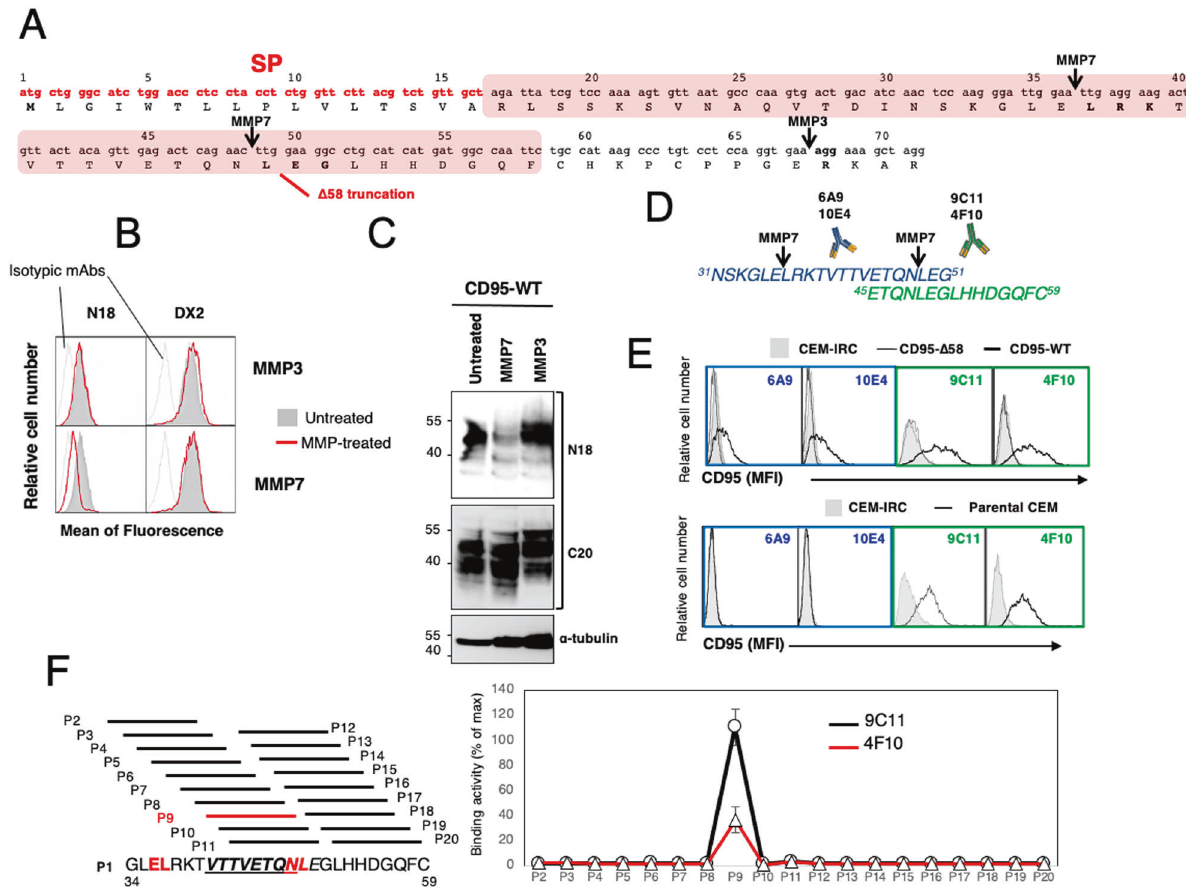
Fig. 3 MMP7-mediated cleavage of the CD95 N-terminal domain. A Schematic representation of the predicted metalloprotease (MMP) cleavage sites in the amino terminal region of CD95 [26]. Box in red refers to the truncated CD95- Δ 58 construct. SP refers to signal peptide. B CEM-IRC cells reconstituted with full-length CD95 were incubated with (red line) or without ( fi lled grey curve) recombinant MMP-3 or MMP-7 (0.1 µg/ml) for 4 h at 37 °C and CD95 expression was assessed by fl ow cytometry using N18 or DX2. Isotypic antibodies for N18 and DX2 are depicted. C CEM-IRC cells reconstituted with full-length CD95 (CD95-WT) were treated as in (B), lyzed and indicated western blotting were performed. Tubulin immunoblot serves as loading control. D The two peptides covering the N-terminal region of CD95 have been injected in mice to generate anti-CD95 mAbs. E Flow cytometry analyses of the CD95 constructs recognized by monoclonal antibodies in ( D ). 9C11 and 4F10 recognize endogenous CD95 (parental cells), while 6A9 and 10E4 fails to recognize it. ( F ). Epitope mapping of 9C11 and 4F10 antibodies as described in Materials and methods. Left panel; indicated overlapping peptides covering the CD95 amino acid residues 34 to 59 are used for epitope mapping. Red amino acids represent the two putative cleavage sites of MMP7. The underlined sequence corresponds to the epitope recognized by 9C11 and 4F10. Right panel ; histograms represent ELISA values for each indicated peptide for 9C11 or 4F10 (ratio of the value for each peptide to the maximum value corresponding to full-length sequence signal). an epitope mapping of 9C11 and 4F10 using CD95 amino acid modi fi cations of the protein ( i.e ., formylation, acetylation) or residues 34 to 59 (Fig. 3F). This showed that 9C11 and 4F10 disul fi de bridge between two cysteines sequestering the recognized the same epitope, namely 41 VTTVETQN 48 (Fig. 3F) and N-terminus. To better map the region of CD95 cleaved by MMP7, peptides covering the amino acid residues 31 – 59 that ruled out the implication of 48 NL 49 as the main CD95 cleavage site encompass the two putative MMP7 cleavage sites (i.e., 36 EL 37 and while strongly supporting that the receptor was processed 48 NL 49 ) were used to generate monoclonal antibodies (Fig. 3D). between glutamic acid 36 and leucine 37 by MMP7. Surprisingly, although the CD95 N-terminal-recognizing N18 Among the selected hybridoma, the 6A9 and 10E4 mAbs were (see Fig. 2A), 6A9 and 10E4 (Fig. 3E) antibodies failed to detect obtained for mice immunized with the 31 NSKGLELRKTVTTVETQN- endogenous CD95 in parental CEM cells, they still stained the full- LEG 51 peptide, while the 9C11 and 4F10 were obtained using the 45 ETQNLEGLHHDGQFC 59 sequence (Fig. 3D). Although all mAbs length CD95 when overexpressed in CEM-IRC cells (see Figs. 1B, E). A possible explanation for this discrepancy is that the CMV recognized full-length CD95 when overexpressed in CEM-IRC cells promoter-driven robust and constitutive expression of full-length (Fig. 3E), none of them interacted with the CD95- Δ 58 constructs CD95 in CEM-IRC cells could overwhelm the endogenous MMP7- (Fig. 3E) con fi rming that the generated antibodies bound epitopes mediated cleavage rate and by doing so, allowed a certain upstream the cysteine at position 59. Interestingly, whereas 9C11 proportion of full-length receptor to escape from MMP7 cleavage. and 4F10 mAbs stained endogenous CD95 in parental CEM T-cells In agreement with this leakage hypothesis, we noticed a lower (Fig. 3E), 6A9 and 10E4 mAbs failed to do so (Fig. 3E) supporting intensity of the N18 staining in CEM-IRC cells expressing full- that endogenous CD95 still possessed the 45 ETQN- length CD95 as compared to the one obtained with DX2 (Fig. 1B LEGLHHDGQFC 59 sequence, which includes the putative MMP7 and Fig. 3B) and similarly, only a reduced quantity of full-length cleavage site 48 NL 49 . To narrow this region down, we conducted Cell Death and Disease (2022)